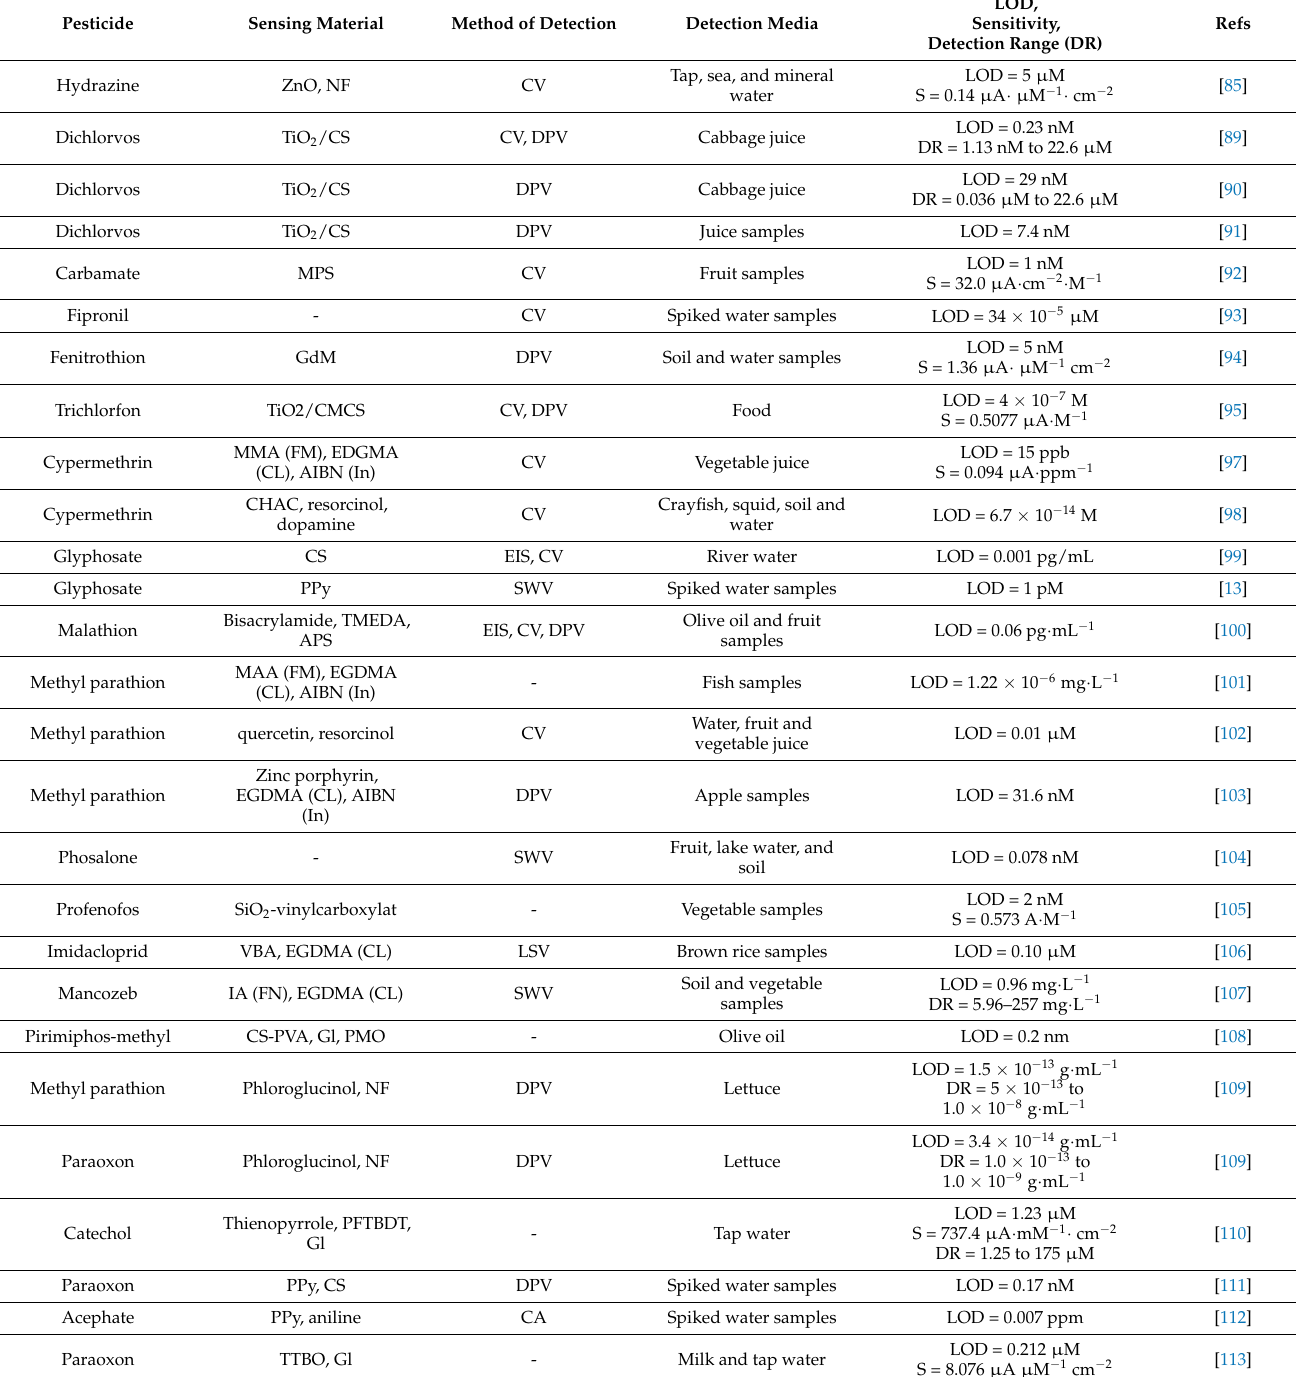
Table 4. Performances of handpicked pesticide electrochemical